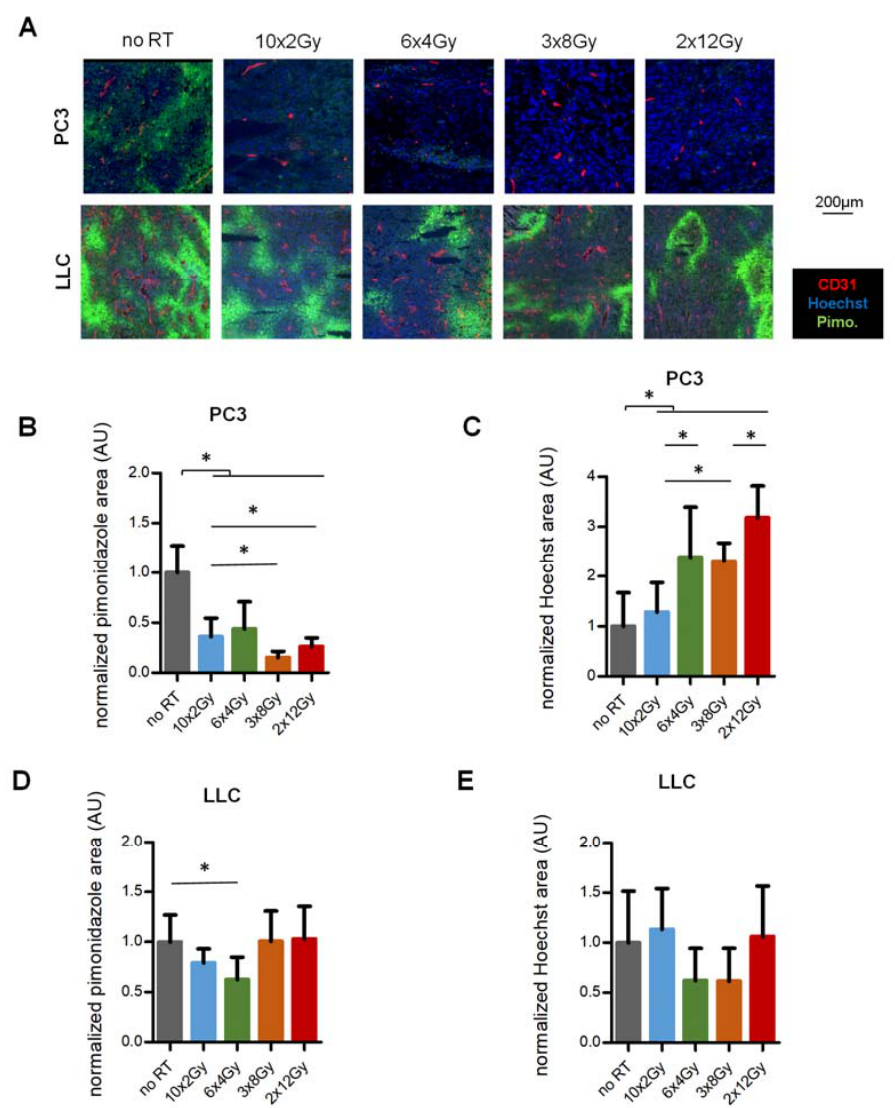
Figure 3. Tumor hypoxia and perfusion in response to RT fractionation schedule. ( A ) Immunohistological staining for hypoxia (pimonidazole) and perfusion (Hoechst 33342) two weeks after RT initiation in PC3 and LLC tumors. ( B , C ) Quantification of hypoxia in PC3 ( B ) and LLC ( C ) tumors at day 15. ( D , E ) Quantification of Hoechst perfusion in PC3 ( D ) and LLC ( E ) tumors at day 15. Images and analysis represent two independent experiments with a total ≥ 18 PC3 and ≥ 15 LLC tumors per point. * indicates p <